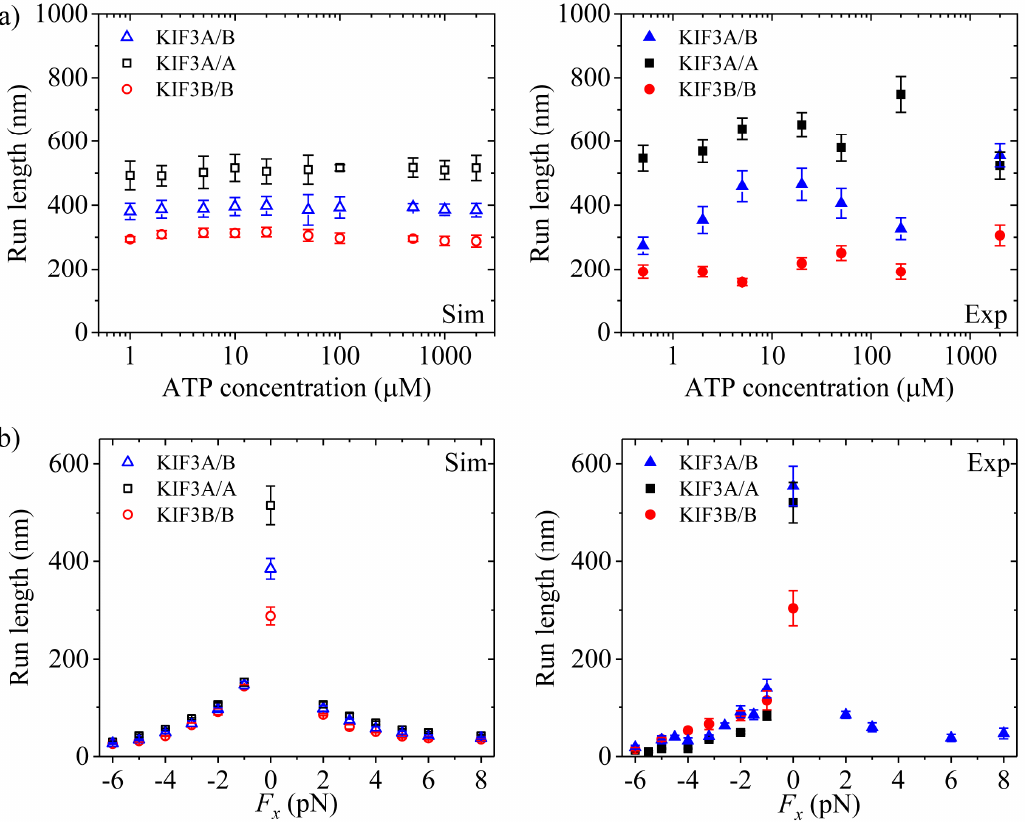
Figure 6. Kinesin-2 run length as a function of [ATP] and force. Left panels show simulated data, while right panels show experimental data taken from Andreasson et al. [8,18]. ( a ) KIF3A / B, KIF3A / A and KIF3B / B run length versus [ATP] at F x = 0. ( b ) KIF3A / B, KIF3A / A and KIF3B / B run length versus F x at [ATP] = 2 mM.